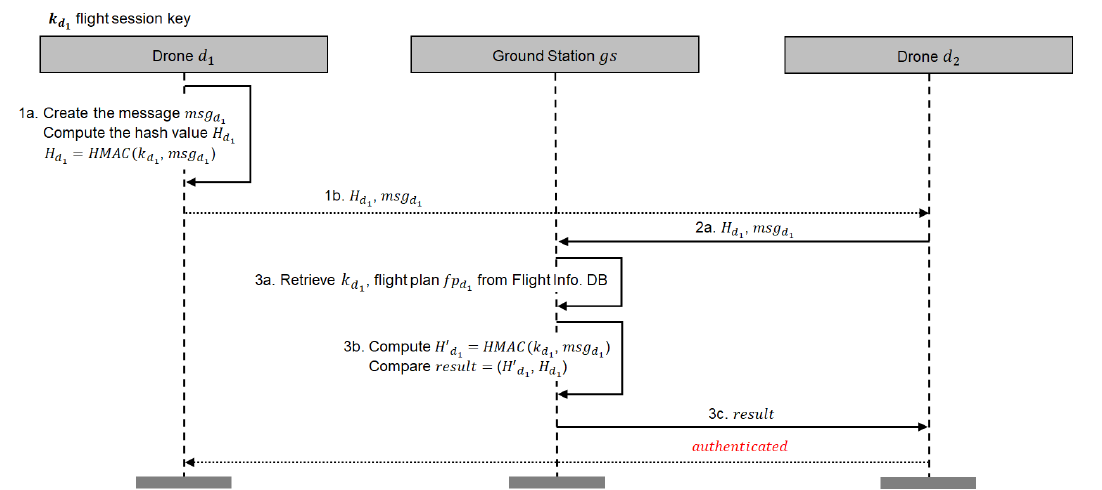
Figure 6. Authentication protocol between drone and